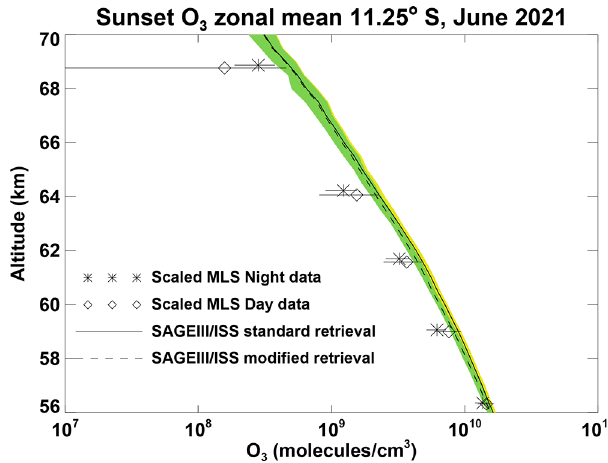
Figure 13. Comparison of sunset SAGE III/ISS and MLS meso- spheric O 3 zonal mean at 11.25 ◦ S in June 2021. Solid line – mean of SAGE III/ISS standard retrieval with the standard deviation shown by the yellow shade; dashed line – mean of SAGE III/ISS modified retrieval with the standard deviation shown by the green shade; asterisks – mean MLS night data scaled to sunset; diamonds – mean MLS day data scaled to sunset; horizontal lines represent the standard